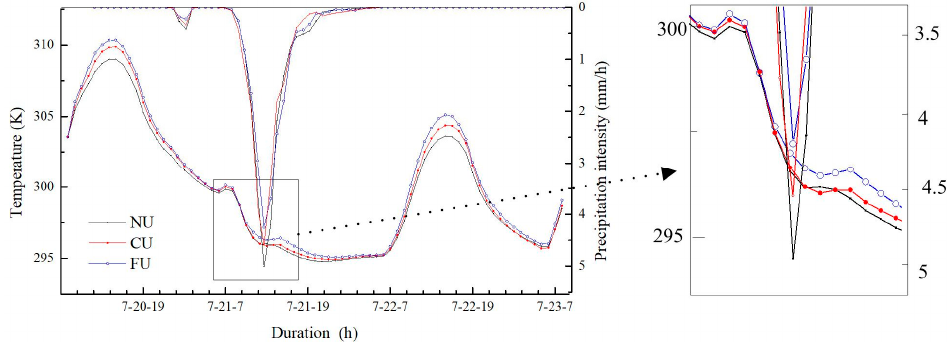
Figure 9. Diagram of mean rainfall and temperature variation with duration during the heavier rainfall event (20–21 July).